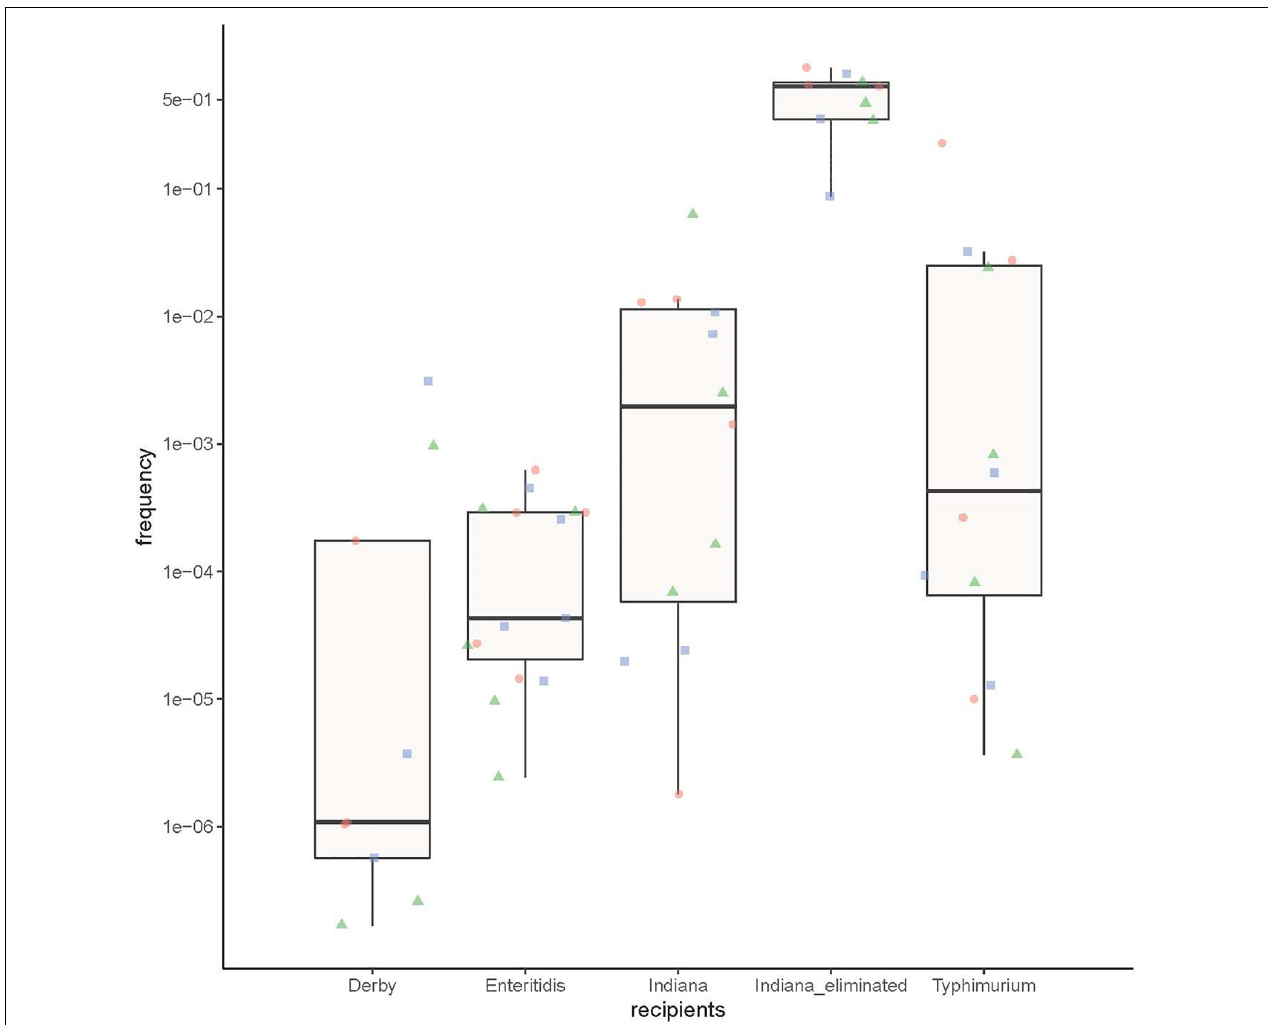
FIGURE 3 | The ability of the different Salmonella serotype strains to obtain an armA -carrying plasmid. Three S. Derby strains, five S. Enteritidis strains, four S. Typhimurium strains, four naturally armA -negative S. Indiana strains, and three S. Indiana strains in which the armA -carrying plasmid was artificially eliminated were used as recipients, and three E. coli J53 strains with different lengths of armA -carrying plasmid ( ∼ 140 kb: green triangles, ∼ 220 kb: red circles, and ∼ 300 kb: blue squares) were used as donors.